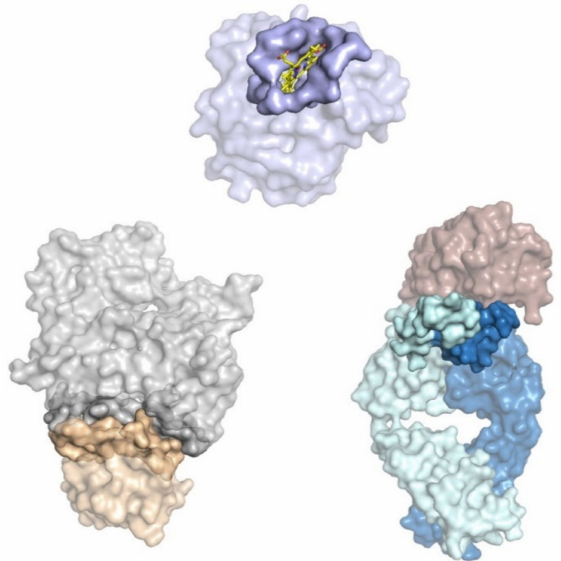
Figure 2. Protein interfaces surface representation. Binding interfaces represented in solid surfaces. At the top, myoglobin (PDB: 1MBN) is shown in purple, with a heme molecule (yellow sticks) bound and the binding pocket in a solid surface. At the bottom left, beta-actin (light gray, top molecule) is shown bound to profilin (wheat, bottom molecule) with their protein–protein interface (PPI) in solid surface (PDB: 2BTF). On the bottom right, a TSH receptor (brick red, top molecule) and antibody (light blue for light chain, dark blue heavy chain, bottom molecule) complex is shown. Only the antibody CDR is highlighted as a solid surface (PDB: